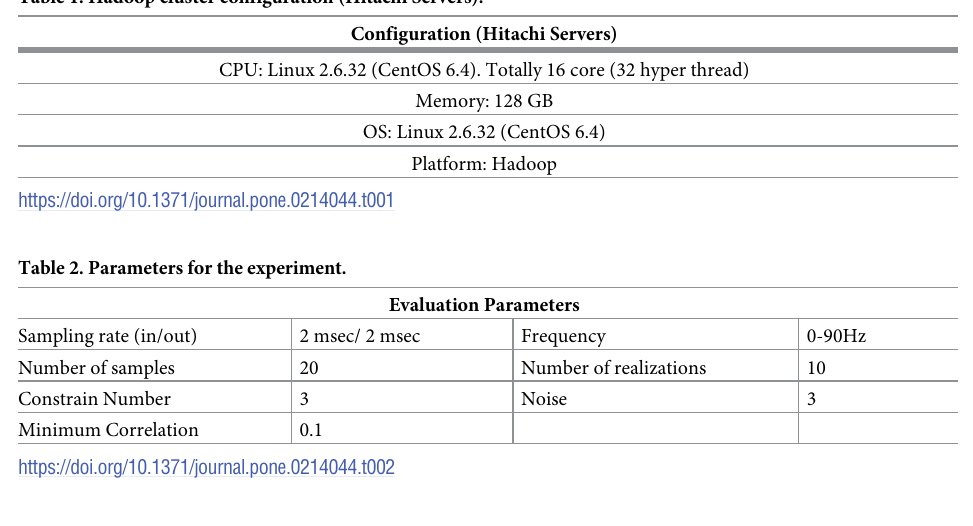
Table 1. Hadoop cluster configuration (Hitachi Servers).